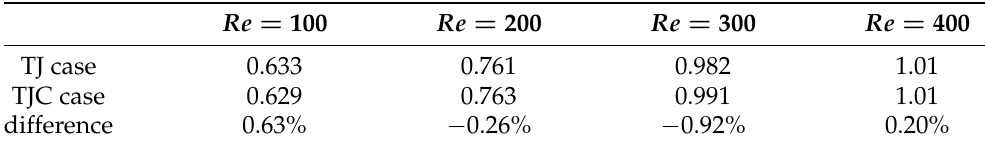
Table 2. Non-dimensional pressure drops in TJ and TJC